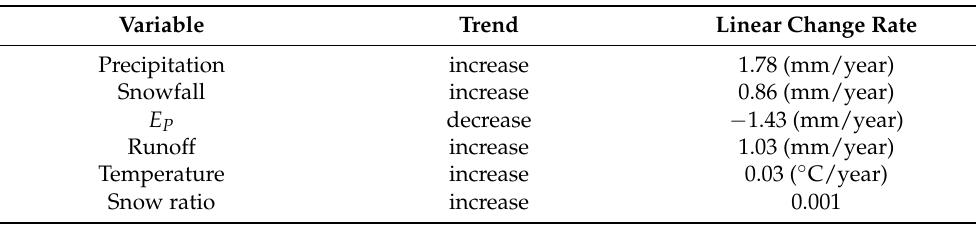
Table 3. The trend of precipitation, snowfall, E P , runoff, air temperature, and snow ratio in the pe- riod from 1960 to 2010.